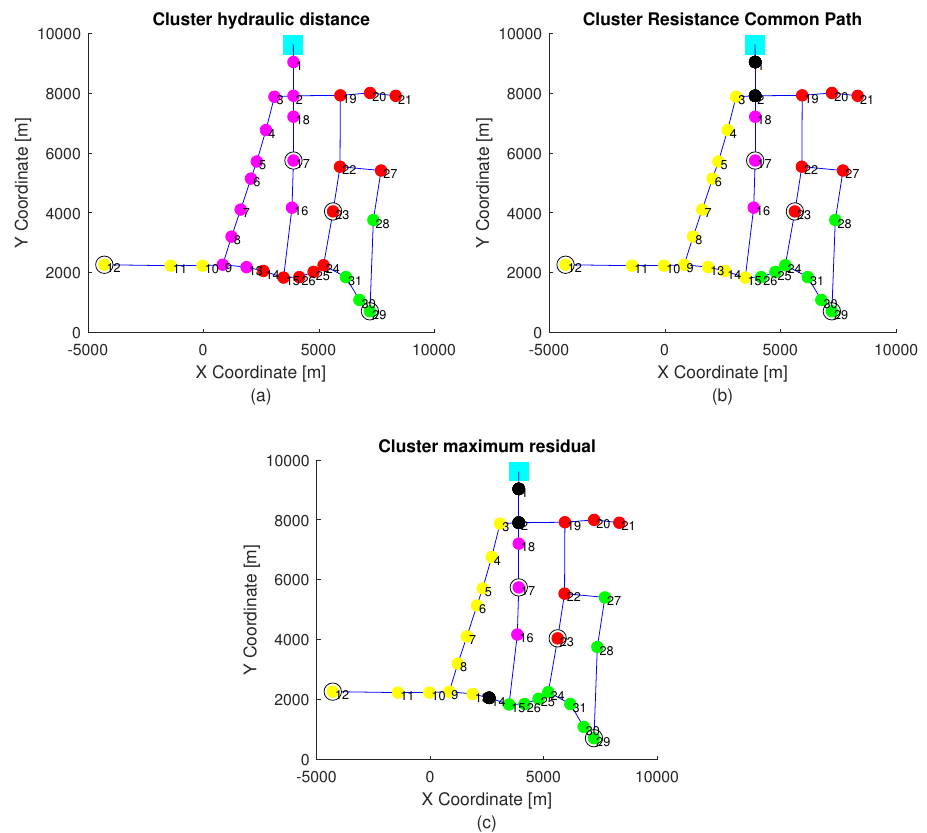
Figure 3. The n s clustering generated with the aspects: ( a ) shortest weighted pipe length, ( b ) The resis- tance takes into account the common path R c ; ( c ) is the maximum residual. Nodes in yellow, violet, j , s i red and green define the cluster related to sensor installed in node 12, 17, 23, and 29,